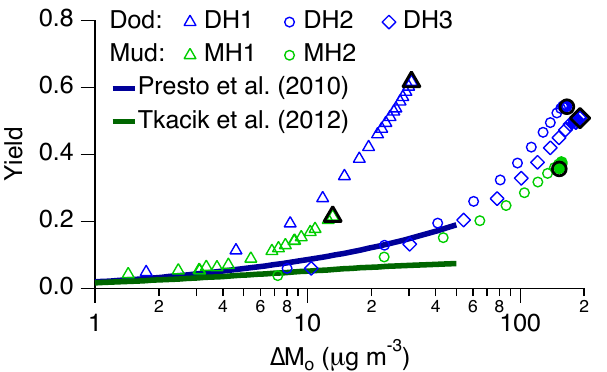
Fig. 3. Comparison of SOA yields as a function of organic aerosol mass concentration, 1M o , observed in the present study with those reported in previous studies. For the present study, final yields (after 95–100% alkane reacted) are denoted by the black